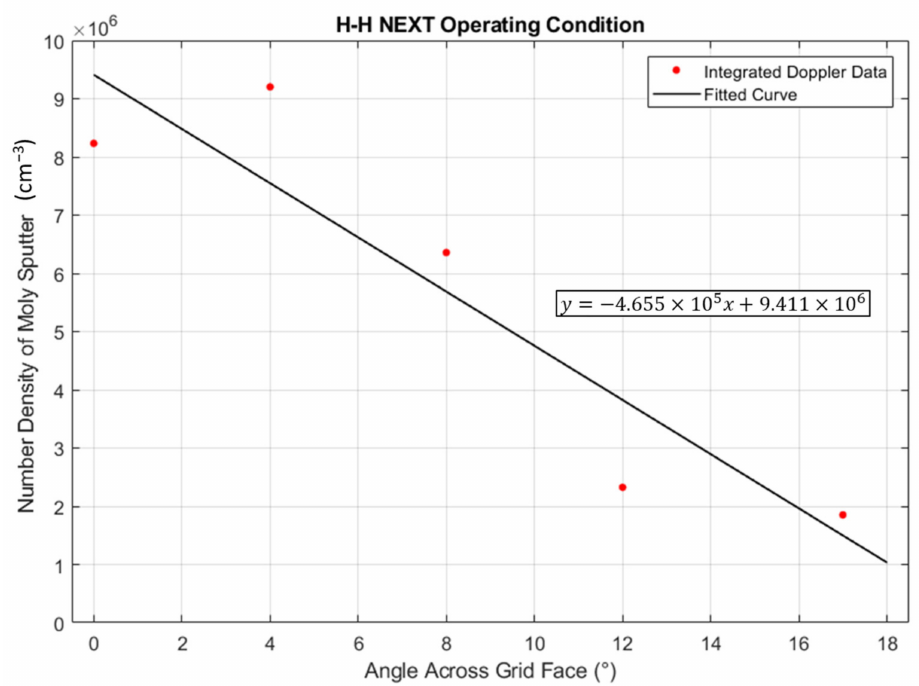
Figure 16. Absolute molybdenum density near the grid face for